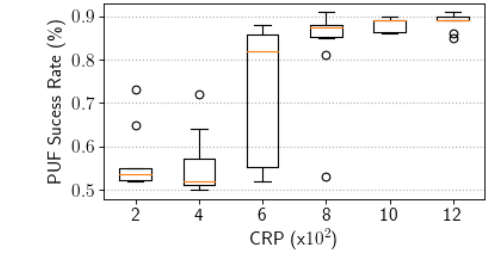
(b) Box plot of the PUF success rate using the mean result of multiple decodings with different reference challenges.